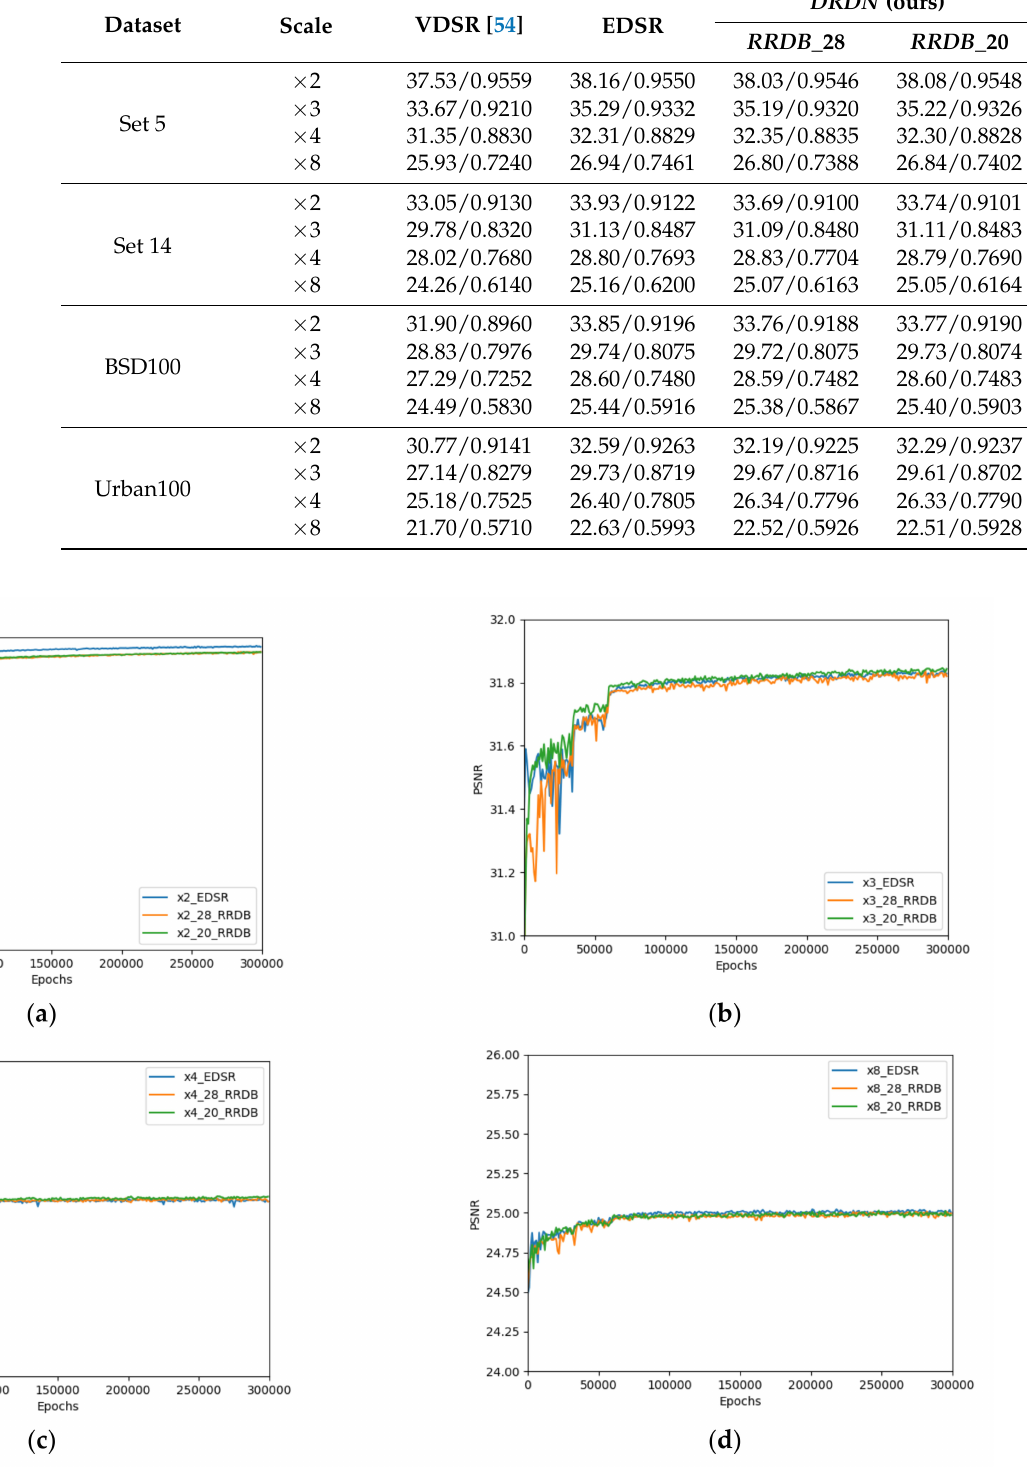
Figure 5. ( a ) Validation of PSNR of EDSR × 2 model and proposed × 2 models ( RRDB _20 and RRDB _28), ( b ) validation of PSNR of EDSR × 3 model and proposed × 3 models ( RRDB _20 and RRDB _28), ( c ) validation of PSNR of EDSR × 4 model and proposed × 4 models ( RRDB _20 and RRDB _28), and ( d ) validation of PSNR of EDSR × 8 model and proposed × 8 models ( RRDB _20 and RRDB